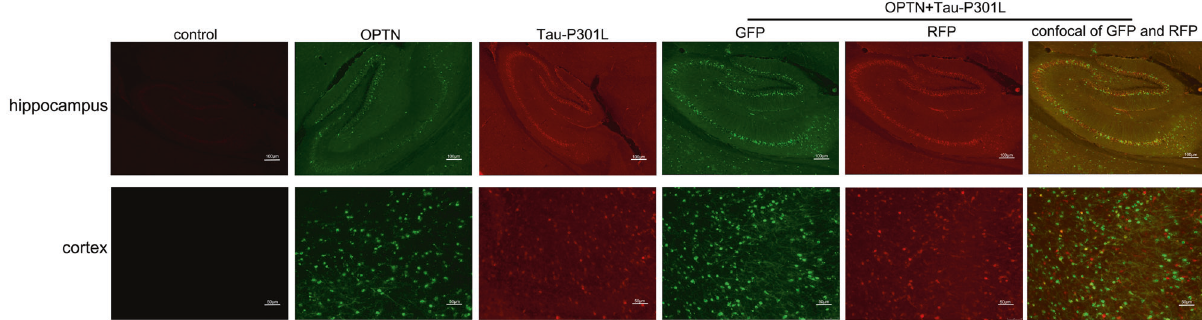
Fig. 3 The brain tissue from 4-months-old mice injected with AAV at P0 phase were visualized by fl uorescent microscopy. GFP green fl uorescent protein, RFP red fl uorescent protein.